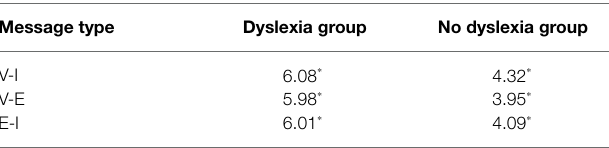
TABLE 1 | Mean RT of answers to three types of messages in two groups with significance levels of Bonferroni’s